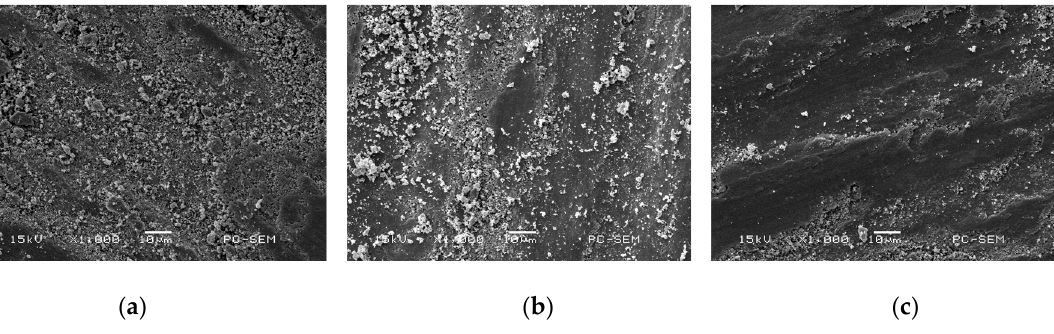
Figure 21. Morphologies of worn track on 24% Cr–76% Ni coating. ( a ) Adhesive wear; ( b ) Crack; ( c ) Spalling off.